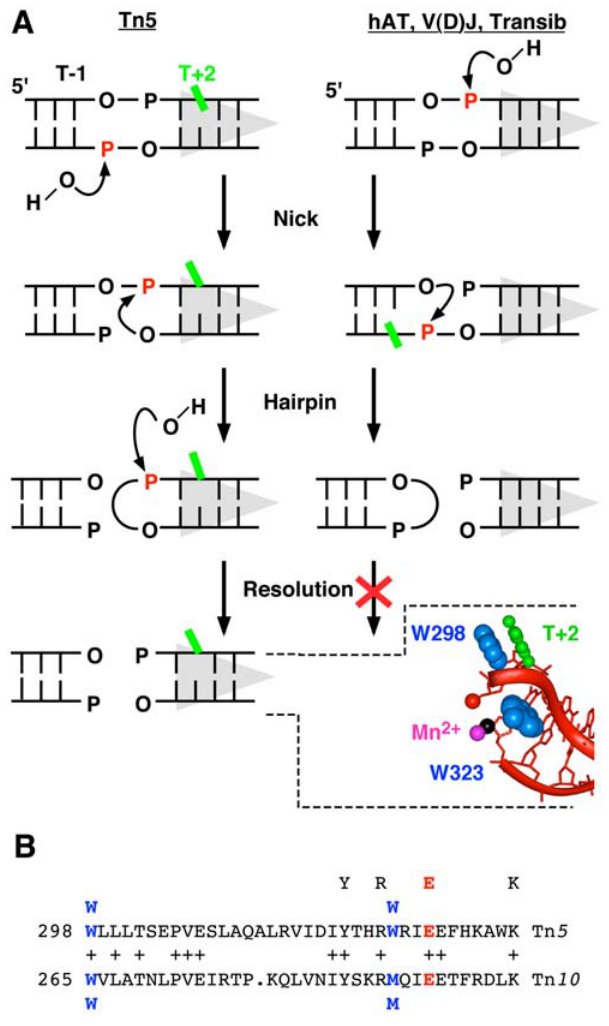
Figure 1. The hairpin and base flipping stages of transposition in different families of transposons. A Different families of DDE transposons have hairpin intermediates of opposite polarity. Scissile phosphates are shown in red; transposon end and RSS, grey triangles. Left panel: Binding of Tn 5 transposase creates a distortion in the DNA that destabilizes stacking of the T + 2 base (green). The first step of the reaction is a nick to expose the 3 9 -OH at the end of the transposon. This facilitates flipping of the T + 2 base from the helix in preparation for cleavage of the second strand by a direct transesterification reaction, generating a hairpin intermediate on the transposon end [35,36]. Subsequently, the hairpin is resolved to yield a blunt transposon end. The insert shows the co-crystal structure of the Tn 5 transposon end, with the flipped base at position + 2 [1]. All of the residues of the bound transposase have been omitted except for two tryptophan residues. One acts as a probe inserted into the DNA helix, while the other provides stacking interactions to stabilize the flipped base. Right panel: In the hAT transposons and V(D)J recombination the polarity of the reaction is reversed. The first nick occurs on the top strand generating a 3 9 -OH on the flanking DNA end [2,37,38]. Transesterification yields a hairpin on the flanking DNA that is processed by the host. Residue -1 on the bottom strand is distorted and becomes permanganate sensitive after the first nick (green) [17]. B The amino acid sequence of the Tn 5 transposase in the vicinity of the probe and stacking residues is aligned with the equivalent region from Tn 10 transposase. The Tn 5 transposase stacking tryptophan is at position 298 and a tryptophan occupies the equivalent position in Tn 10 transposase. However, the Tn 5 transposase